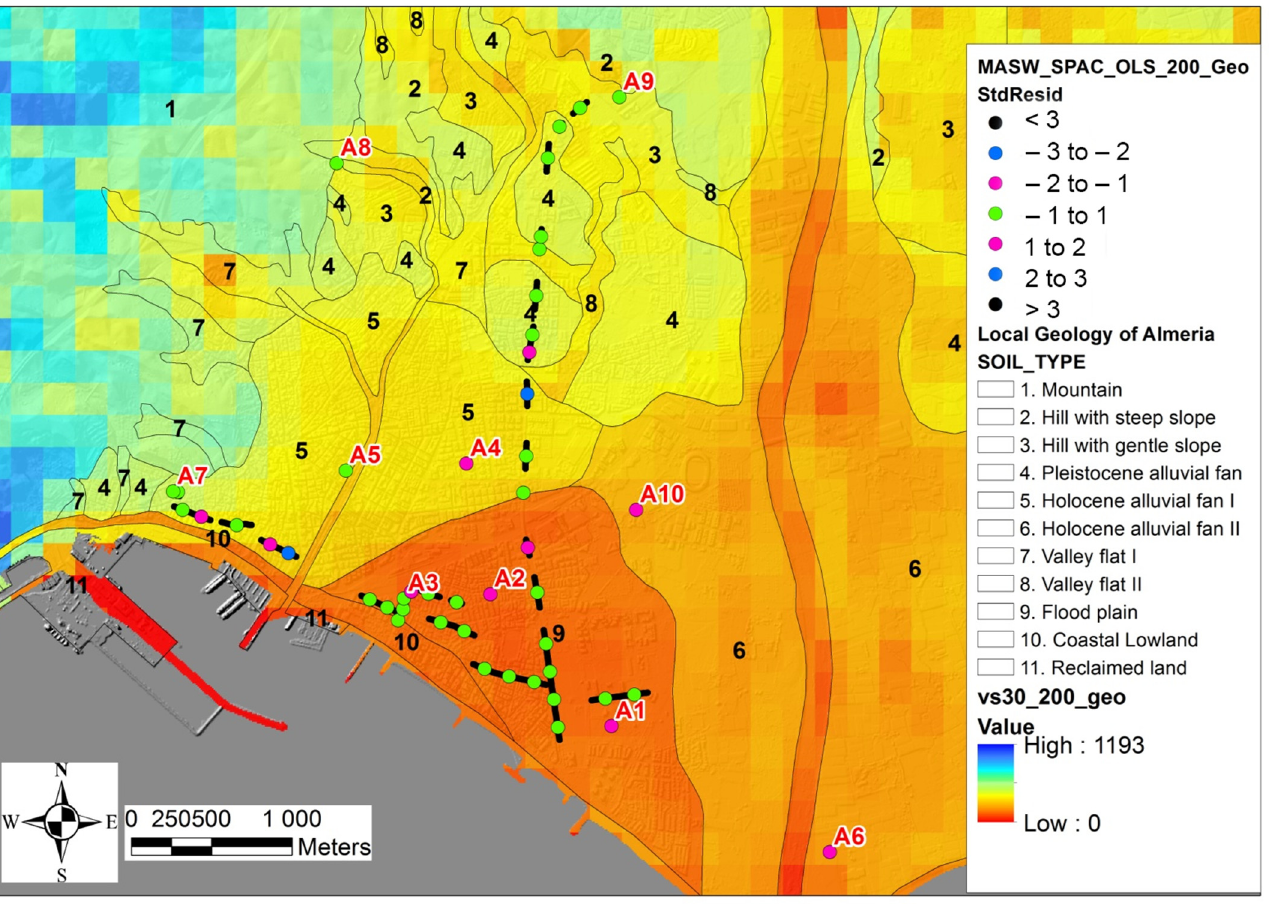
Figure 11. Predicted V s30 map of Almeria city from the correlation using geological units and slopes (MRS 86.9%) for the sampled area, and the correlation with slope only (MRS 79.1%) for the rest of the municipality. The V s30 observations (SPAC and average MASW) are represented by dots with a different color according to the standardized residuals between the predicted and the observed values.